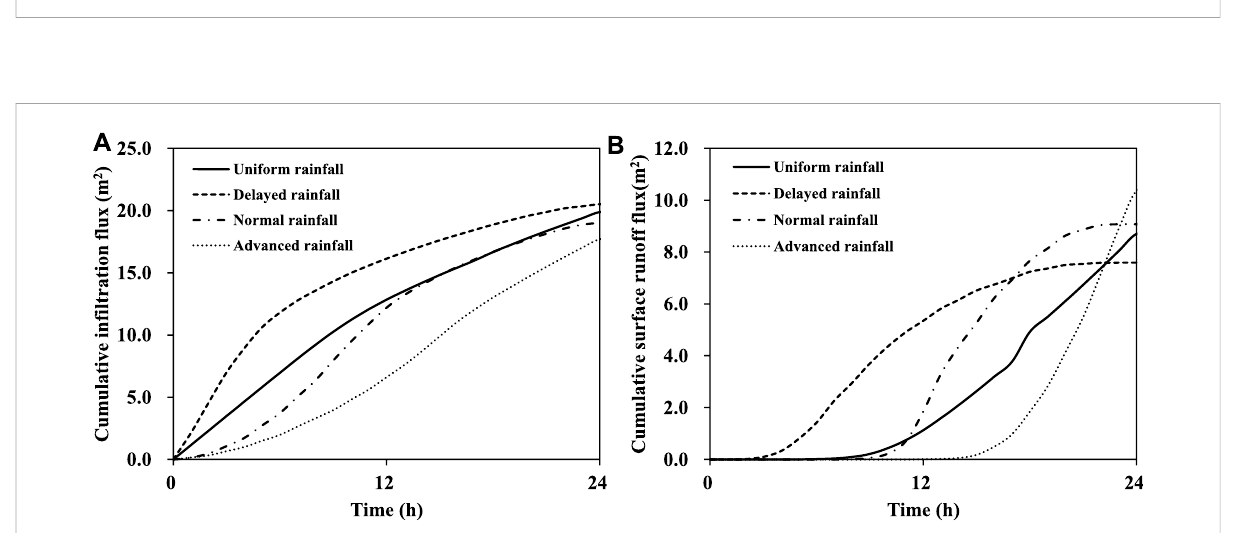
FIGURE 10 Result of fl ux analysis on atmospheric boundary condition under four rainfall pattern (A) cumulative in fi ltration fl ux and (B) cumulative surface runoff fl